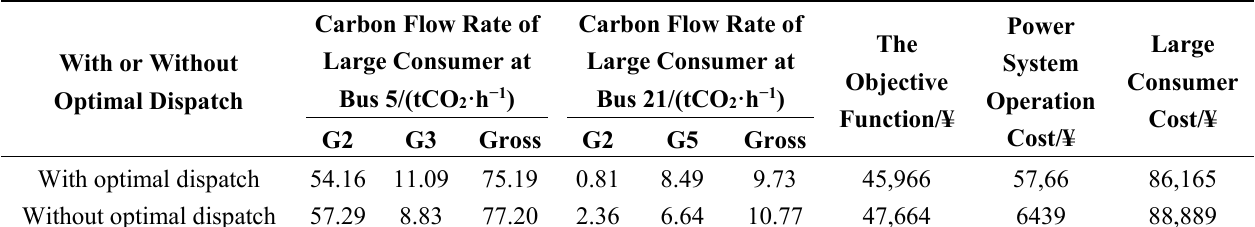
Table 7. The optimal dispatch results of the system with two large